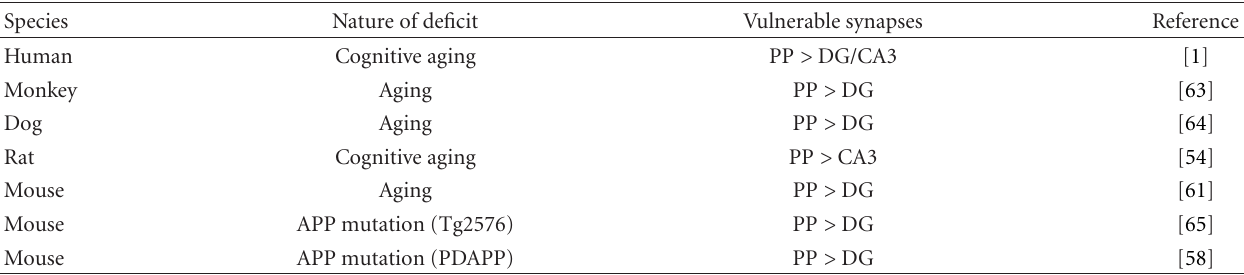
Table 1: Selective vulnerability of synaptic connections between entorhinal layer II neurons and their targets in the hippocampus across di ff erent species during aging and in models relevant to Alzheimer’s disease. In this table, “cognitive aging” refers to studies where correlations with memory deficits were observed in aged populations, while “aging” refers to studies comparing across di ff erent time points without behavioral assessment. PP: perforant path; DG: dentate gyrus; APP: amyloid precursor